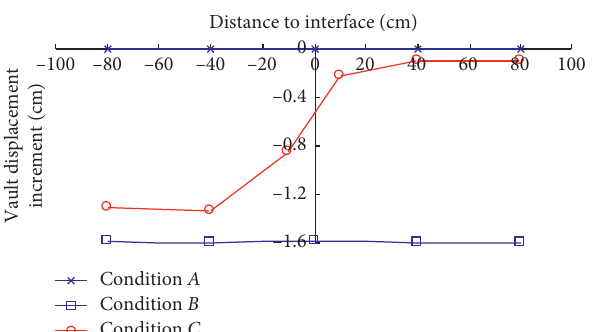
Figure 9: Forced displacement of vault at different monitoring sections.